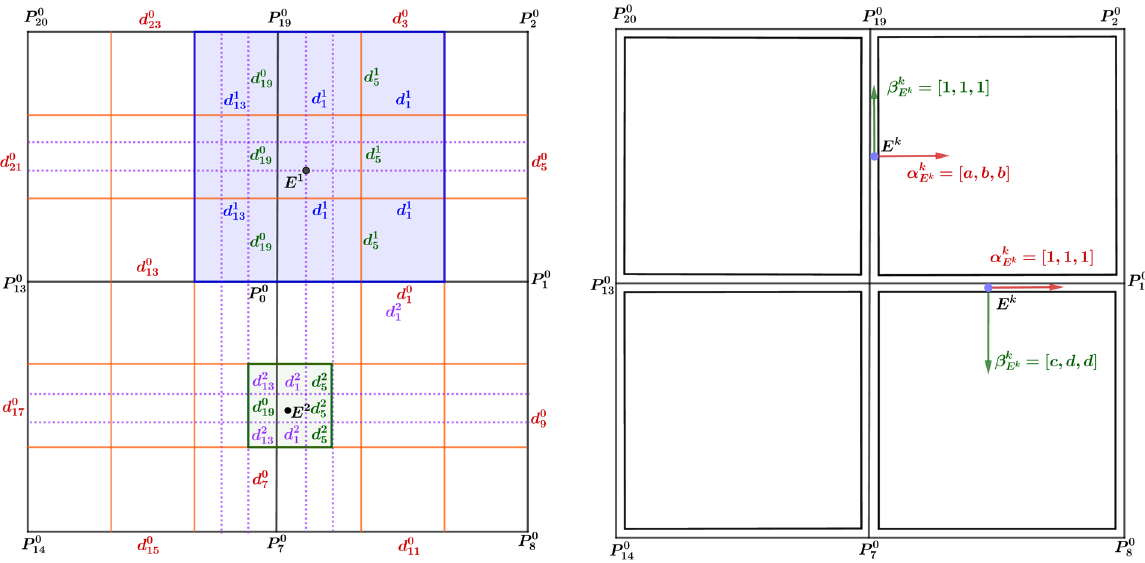
Figure 9. Updating of the mask parameters around the edge point after two subdivisions and three subdivisions. Left: after two subdivisions and three subdivisions, the mask parameters of E 1 and E 2 . Right: the mask parameters after several subdivisions.